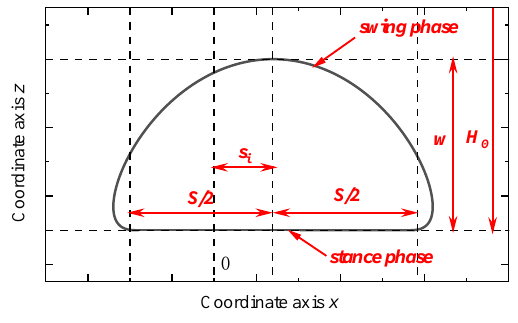
Figure 7. Foot trajectory curve.